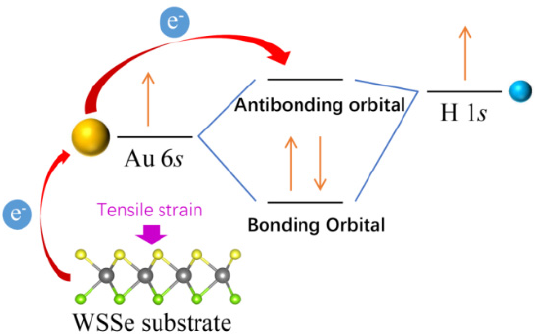
Figure 7. The schematic diagram of the mechanism of external tensile strain affecting adsorption capacity of Au/WSSe for H atom.